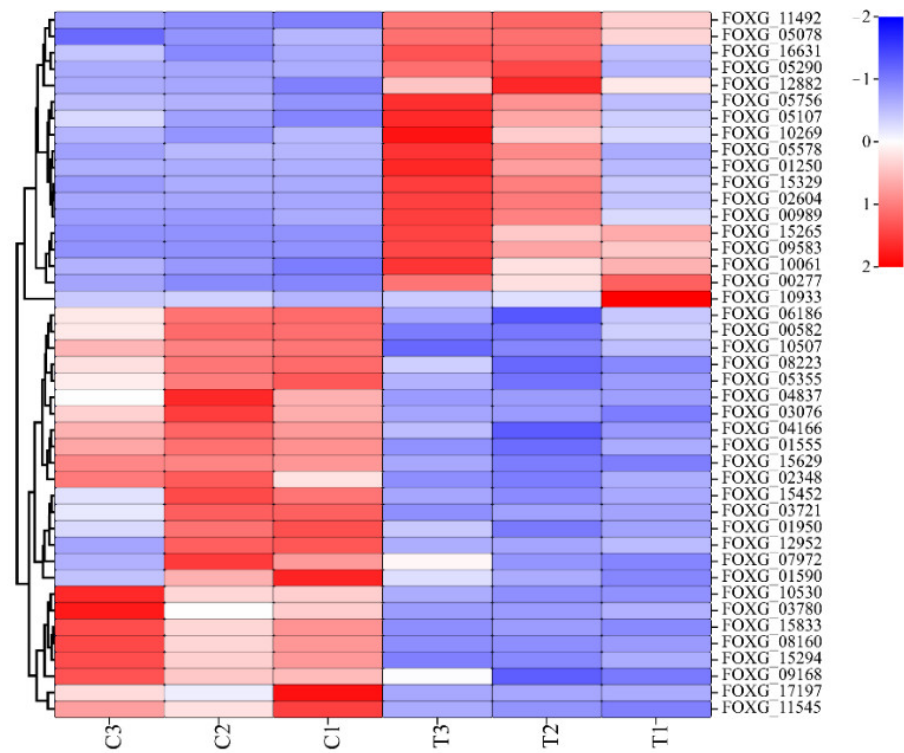
Figure 8. Heatmap of cell wall and membrane, antioxidant damage, and autophagy-related DEGs. The color scale indicates the counts of gene expression normalized by Z-score. “C1, C2, and C3” indicates the three replicates of the control group. “T1, T2, and T3” indicates the three replicates of the treatment group.